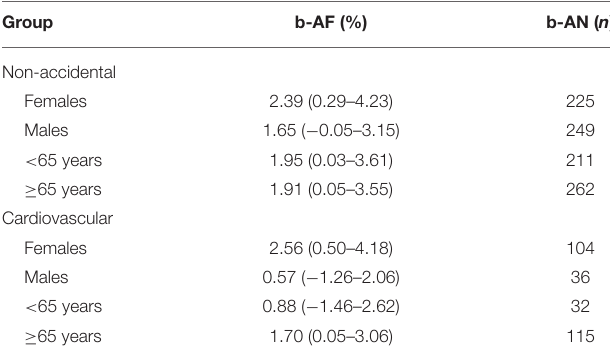
TABLE 4 | The attributable fraction and number of non-accidental and cardiovascular mortality stratified by sex and age. Group b-AF (%) b-AN ( n